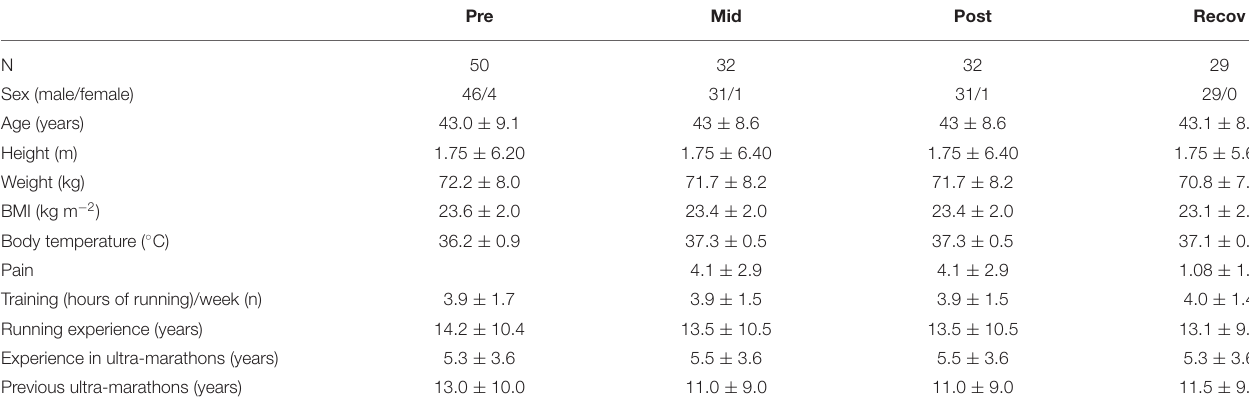
TABLE 1 | Demographic and training profile data.